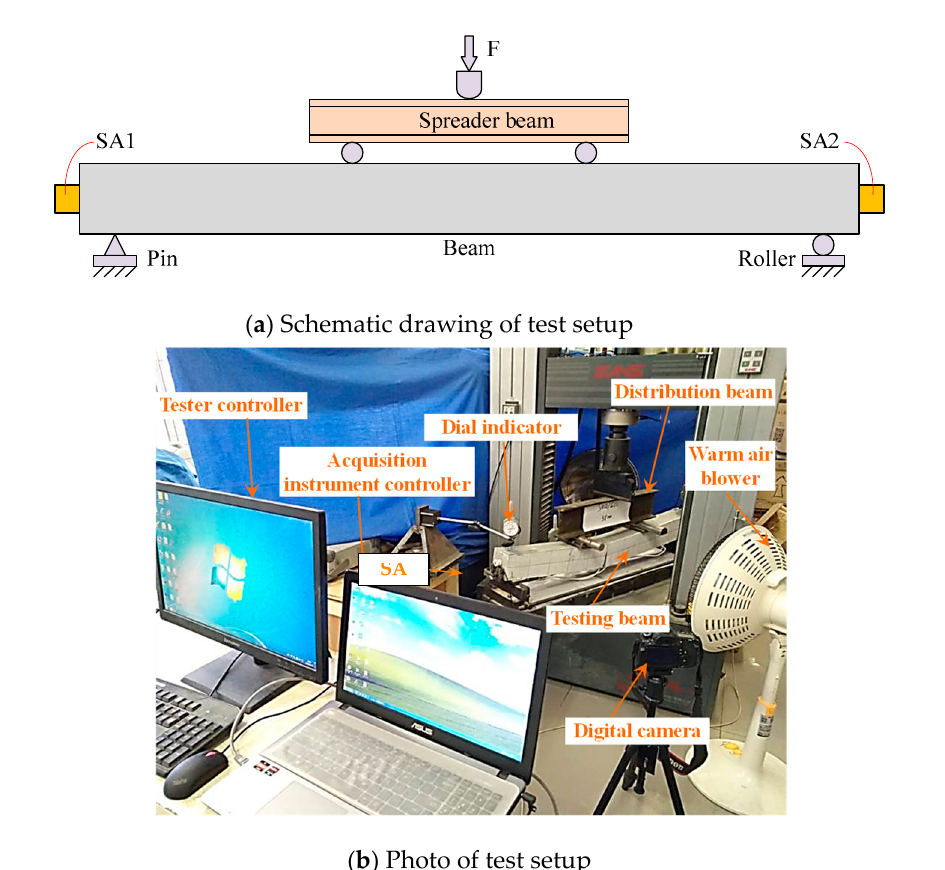
Figure 6. Test setup.